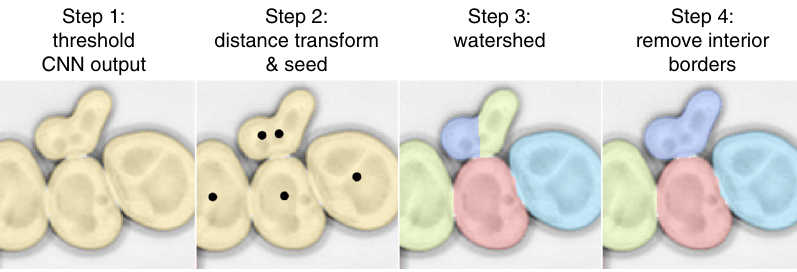
Fig. 3 Steps to segmentation: (1) threshold the CNN output, (2) fi nd the peaks of the distance transform ( = seeds), (3) watershed, (4) remove erroneous interior borders using a cell – cell boundary test. Phase contrast image inverted for better visualization. Image from ref. 16 , scale bar